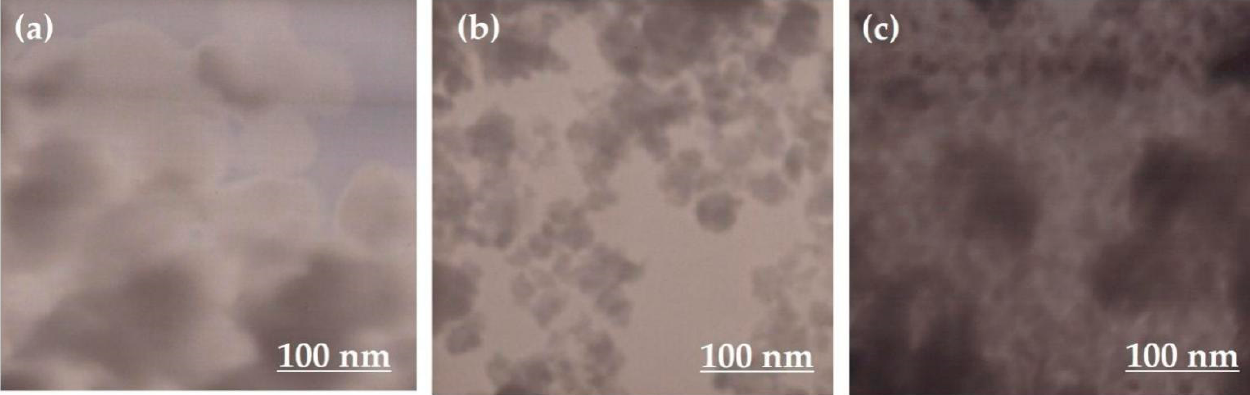
Figure 7. TEM images of different sizes of TiO 2 NPs attained from ( a ) Bacillus subtilis [79], ( b ) Cassia fistula , and ( c ) hydrothermal heating [80].